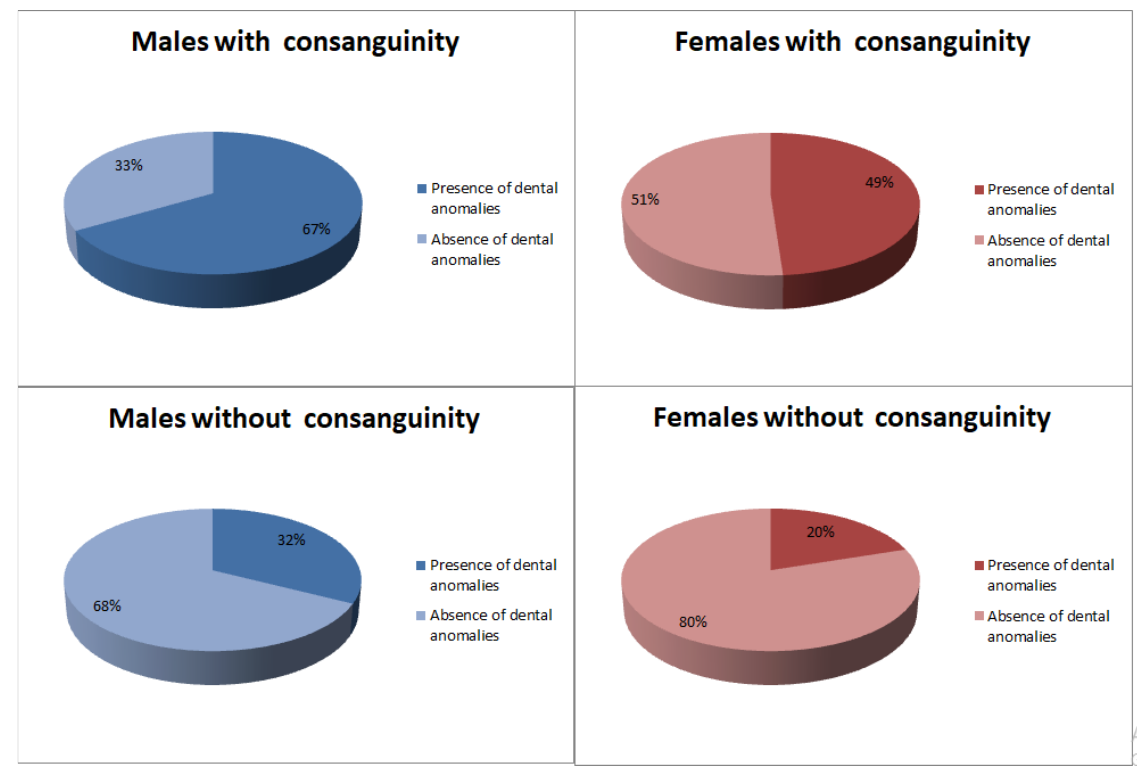
Figure 5. Percentage of dental anomalies among men and women according to relative marriages (All percentages were rounded off to the nearest integer).